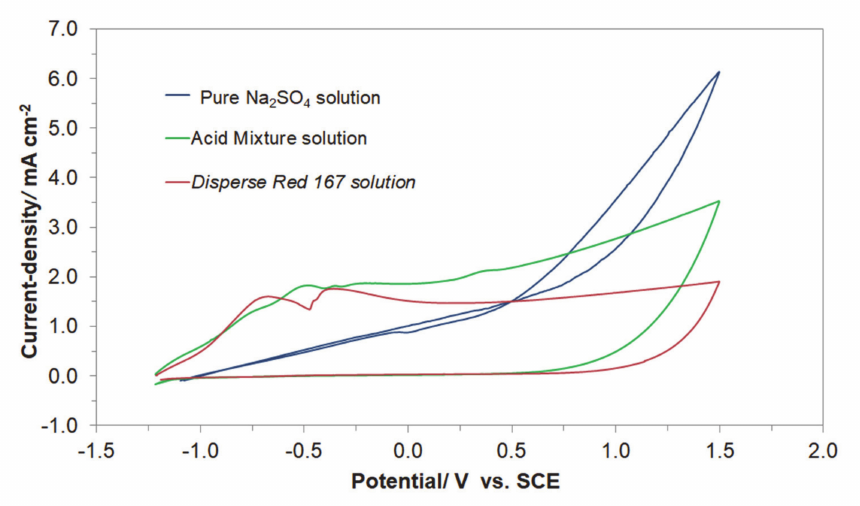
Figure 4. Cyclic voltammograms recorded for Al alloy anode in 0.054 M Na 2 SO 4 electrolyte and in the presence of Acid Mixture, and Disperse Red 167 dyes, both at the concentration of 50 mg dm − 3 , at a sweep-rate of 50 mV s − 1